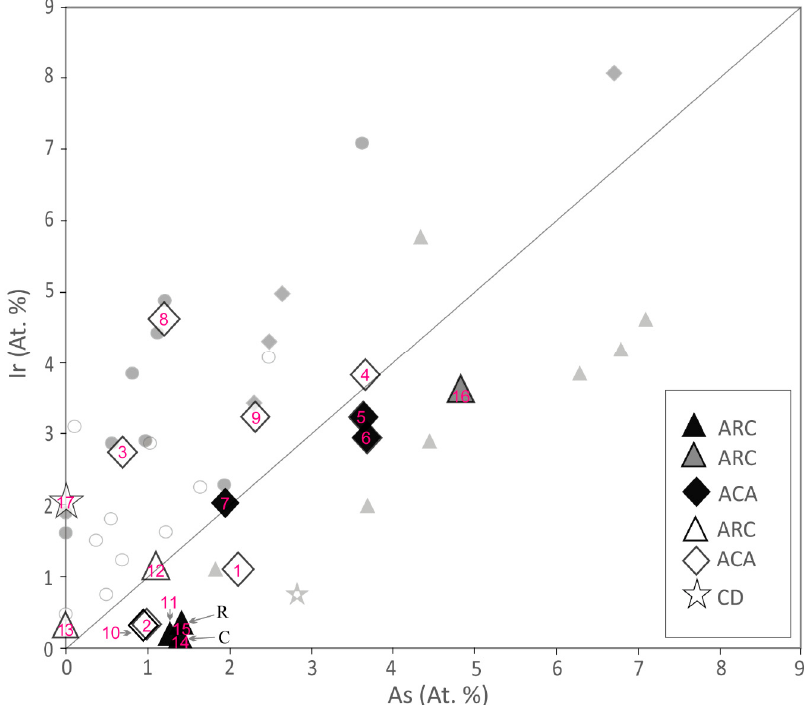
Figure 8. Plot of lr versus As (at %) for laurite-erlichmanite from the Ojén ultramafic Massif, updated from [1,6]. Black polygons correspond to grains displaying normal zoning and dark-grey for oscillatory zoning (C = core; R = rim). The different acronyms for the chromitite bodies referred in previous works of study are ACA and ARC for Arroyo de los Caballos and CD for Cantera de Dunitas. Symbols from this study follow the same code used in [1], to the exception of grey circles corresponding to analysis of Arroyo de los Caballos (undifferentiated) and white to Cerro de Águila from [6]. Numbers correspond to EPMA results showed in the Table 1. Literature and new data define positive correlation trends parallel to the Ir: As = 1 line.